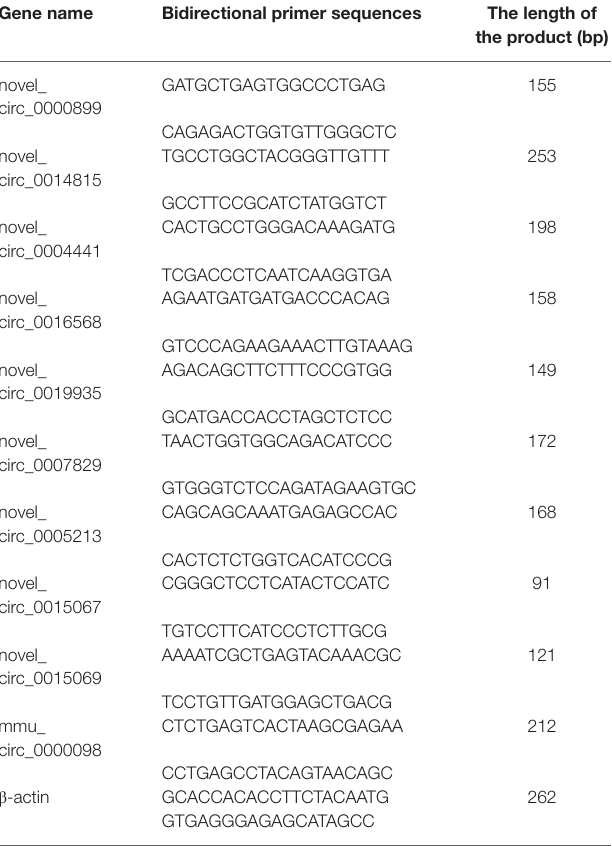
FIGURE 4 | Gene Ontology (GO) and Kyoto Encyclopedia of Genes and Genomes pathway analyses results. (A) GO enrichment map of circRNA host genes. BP, biological process; CC, Cellular component. (B) The X-axis represents the rich factor, the Y-axis represents the name of the pathway, the size of the dot indicates the number of source genes in this pathway, and the color of the dot corresponds to different q value